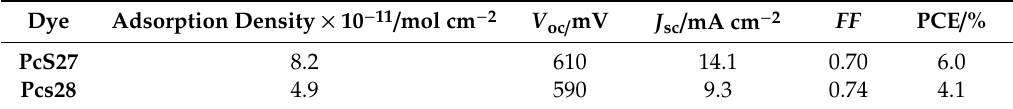
Table 1. Photovoltaic performance of DSSCs sensitized with PcS27 and PcS28